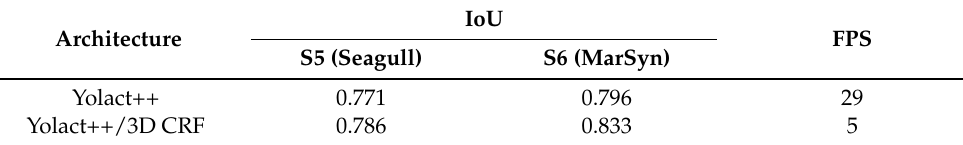
Table 5. Segmentation results with and without 3D CRF post-processing